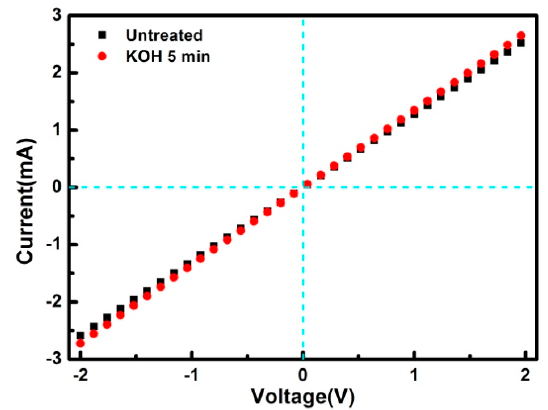
Figure 9. Measured I – V curves for untreated and the KOH-treated before Pd(10 nm)/Ni(10 nm)/Au(30 nm) contact evaporation on GaN laser diode.